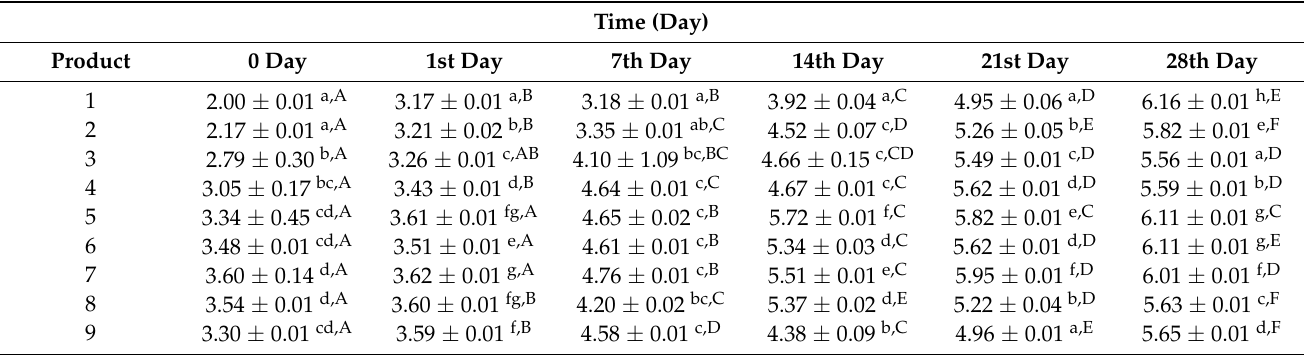
Table 2. Effect of addition of flaxseed mucilage (FM), gum arabic (GA), yogurt culture (YC) and B. lactis (B.L) on L. acidophilus count (log CFU/ mL) in kefir samples during storage time.